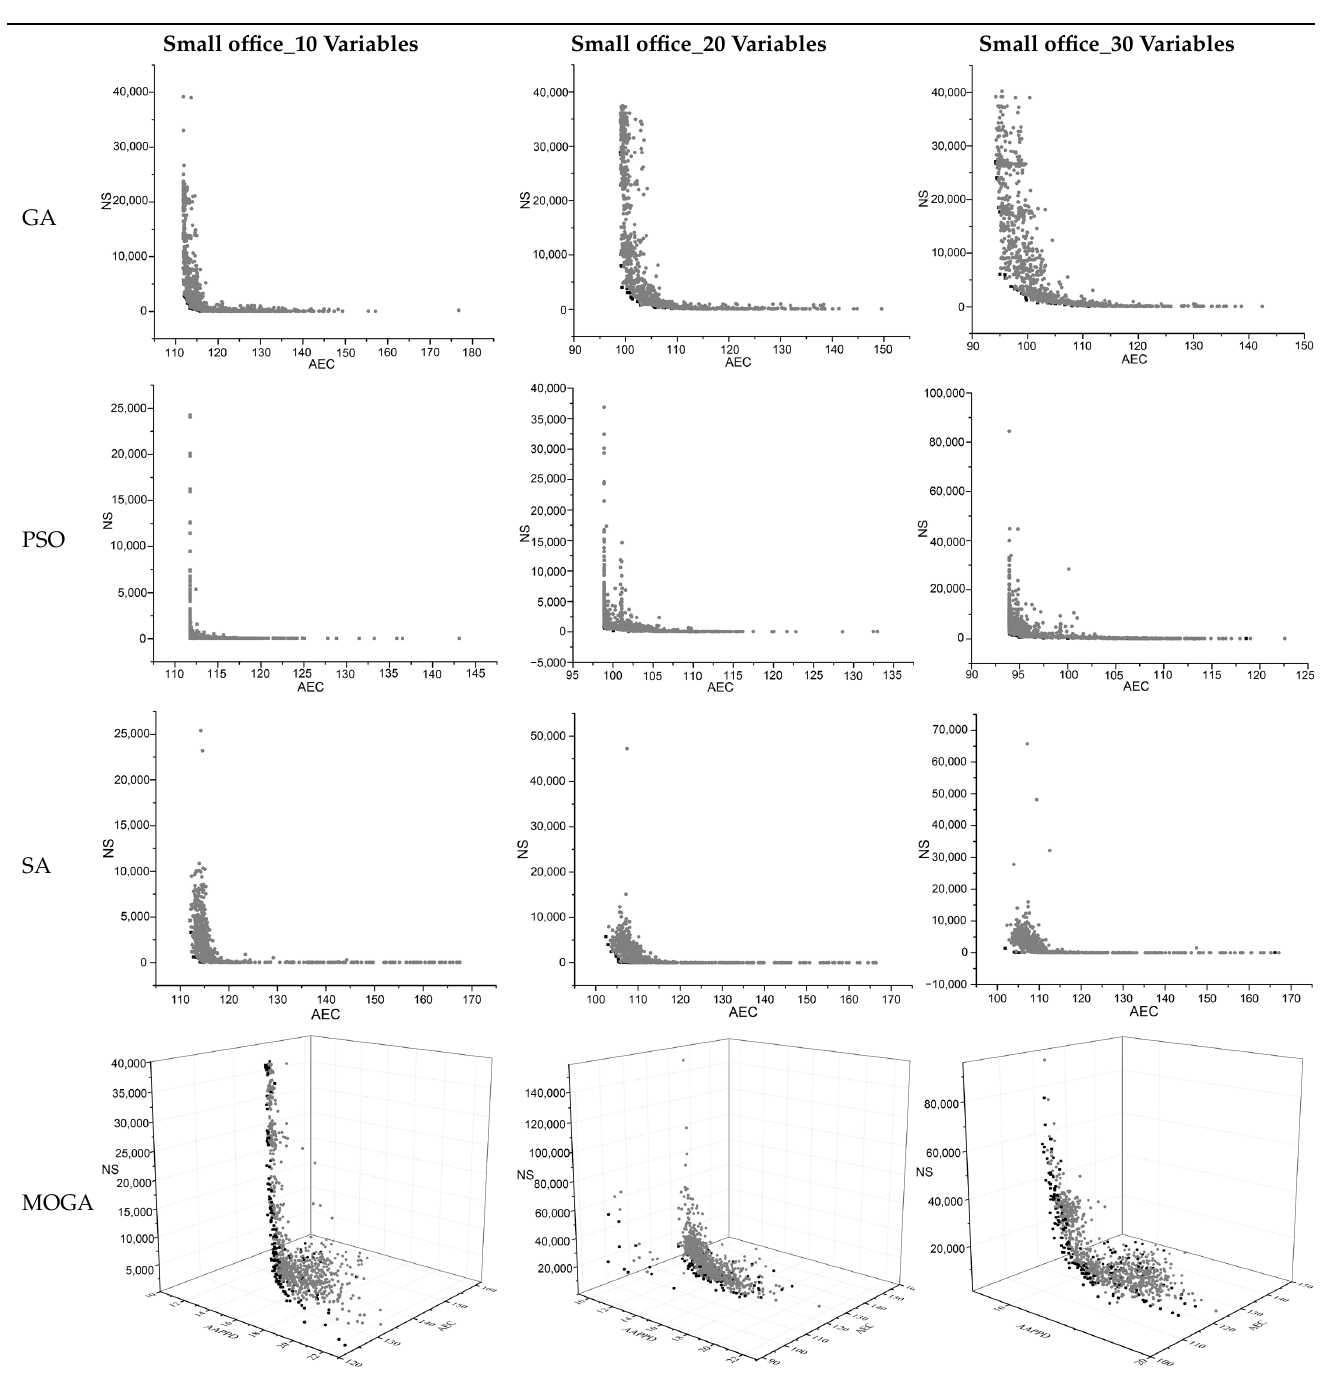
Table A1. The hyperparameter optimization convergence graphs of the four test algorithms.